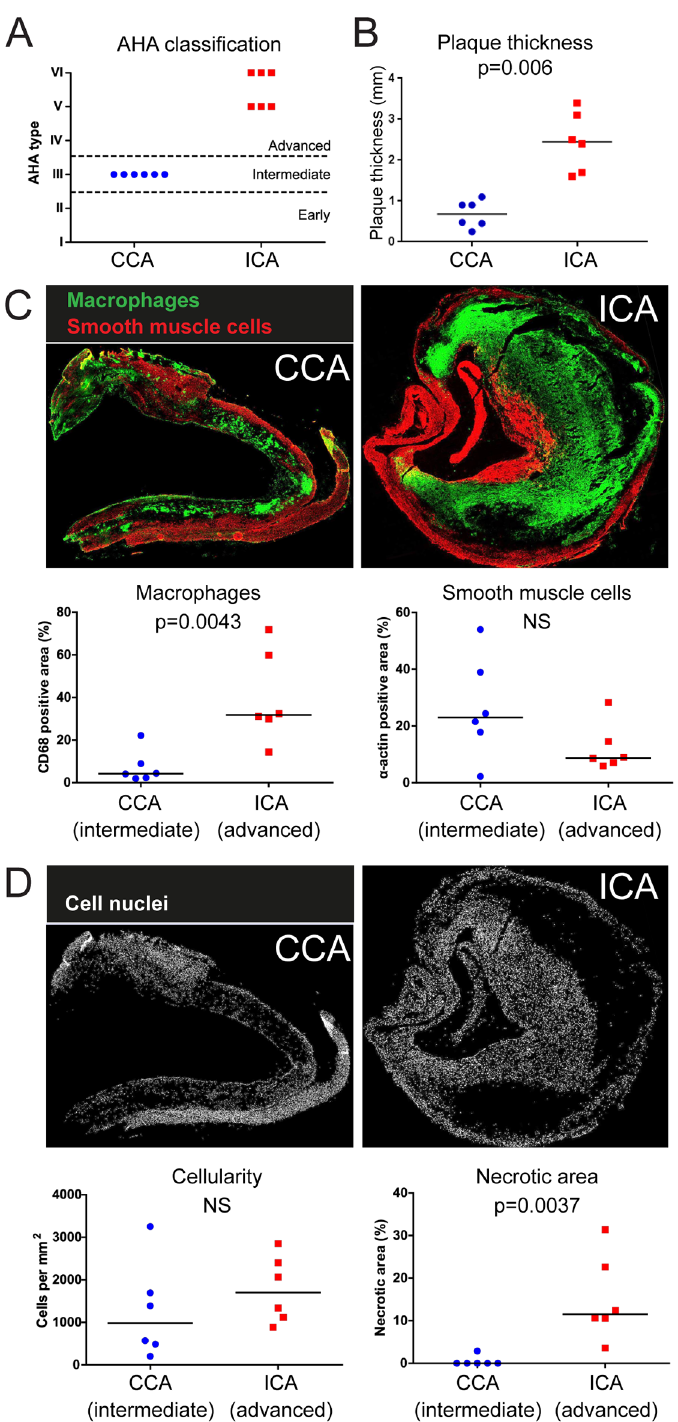
Fig 1. Plaques were intermediate in common carotid artery(CCA) and advanced in internal carotid artery(ICA). A. Plaqueswere obtainedfrom CCA and ICA of human endarterectomies. Plaquesin CCA were intermediate and plaquesin ICA were advanced.B, C and D. Advancedplaqueswhere thicker (B) and had highermacrophage content than intermediate plaques(C). There was no significantdifference in smooth muscle cell content (C) or cellularity (D). Necrotic areas were larger in advancedplaques(D). n = 6, t-test (B) or Wilcoxon Signed-Rank Test (C and D).